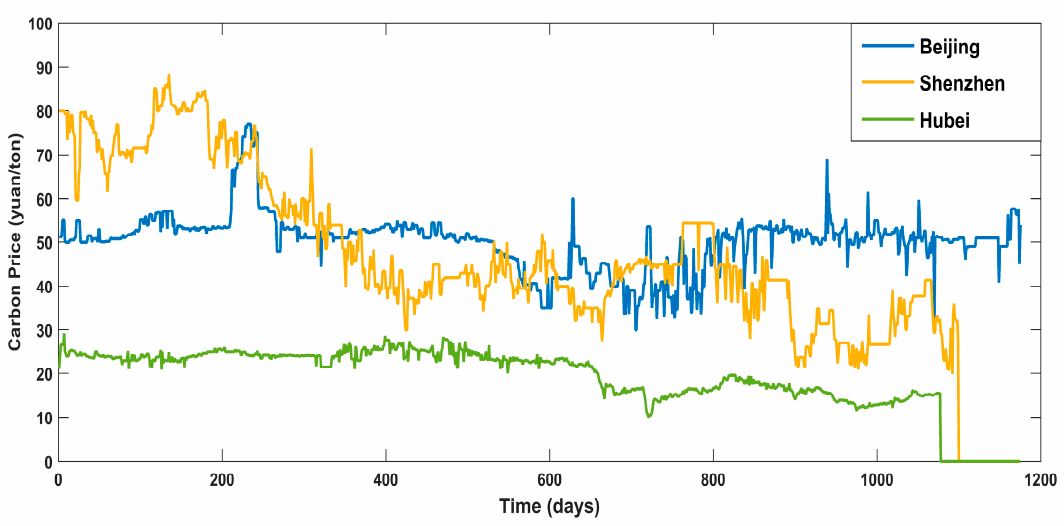
Figure 4. The carbon price graph of the three regional carbon markets.